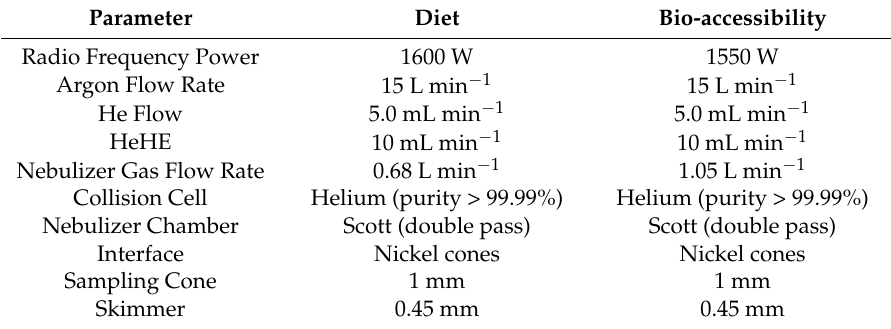
Table 1. Operational conditions for ICP-MS in total diets analyses and bio-accessibility.